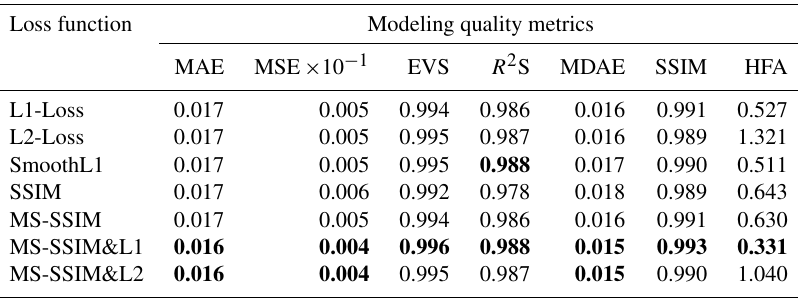
Table 2. A quantitative analysis of our network trained with the distinct loss functions using multiple modeling quality metrics. For each of the quality metrics, the best modeling result is highlighted in